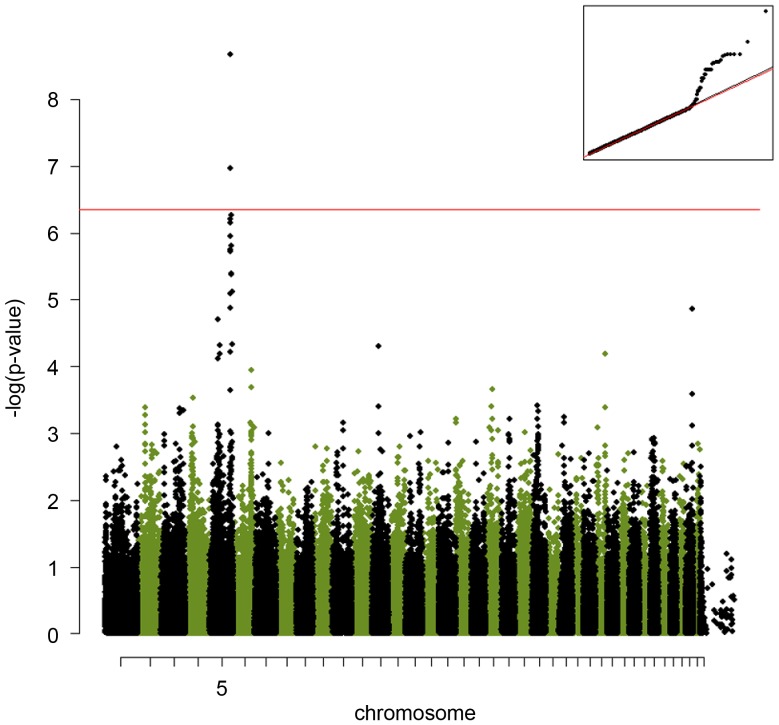
A genome-wide association study of the IgE-responsiveness to A. siro in Labrador Retrievers performed using a mix-model approach efficiently corrected for the population stratification.The red line indicates the Bonferroni-corrected significance level (p<3.9×10−7). The Quantile-quantile (QQ) plot shows the observed versus expected log p-values (on the top-right). The straight line on the QQ plot indicates the distribution of SNP markers under the null hypothesis and the skew at the right edge indicates that these markers are stronger associated with the A. siro IgE response than it would be expected by chance.